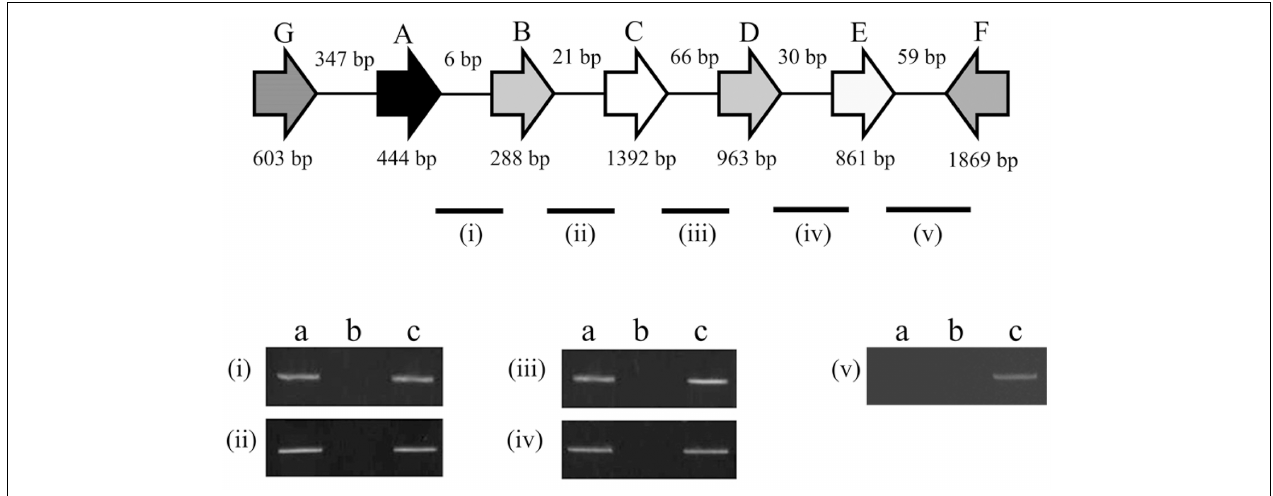
FIGURE 2 | Schematic diagram of the genetic organization of KPN00353 (A), KPN00352 (B), KPN00351 (C), KPN00350 (D), KPN00349 (E), KPN00348 (F) and KPN00354 (G) in K. pneumoniae MGH 78578. Arrows denote the direction of transcription. Each line indicates a junction (i, ii, iii, iv, and v) between the ORFs. The RNA extracted from wild-type K. pneumoniae was analyzed by RT-PCR (a) or PCR (b). The genomic DNA of the wild-type strain was analyzed by PCR as a positive control